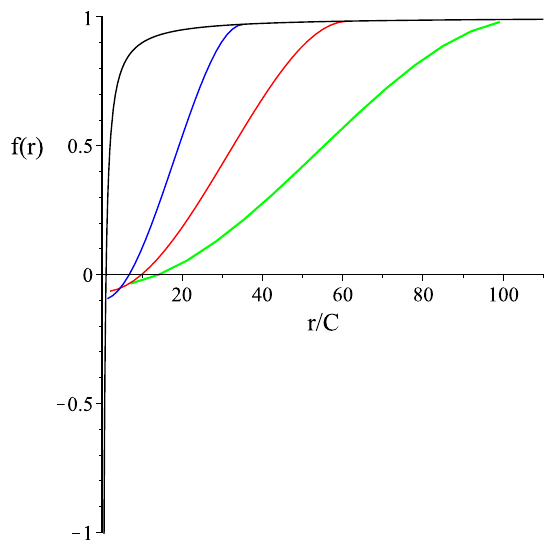
Figure 1 . Numerical solution (color online). A plot showing numeric solutions for an asymptoti- cally (cid:13)at black hole in the quartic theory. The black curve corresponds to the usual Schwarzschild solution of Einstein gravity. The blue, red and green curves correspond to K = (cid:0) 0 : 32 ; (cid:0) 1 ; (cid:0) 3